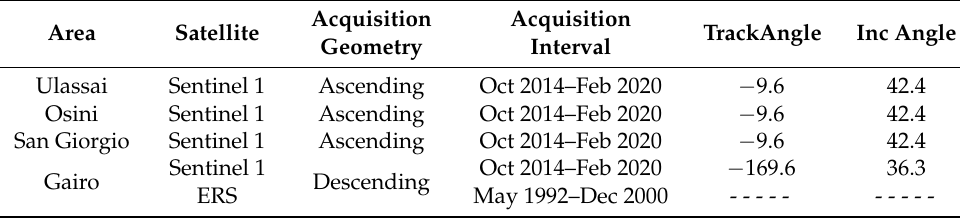
Table 1. Parameters of the InSAR data on the sectors in